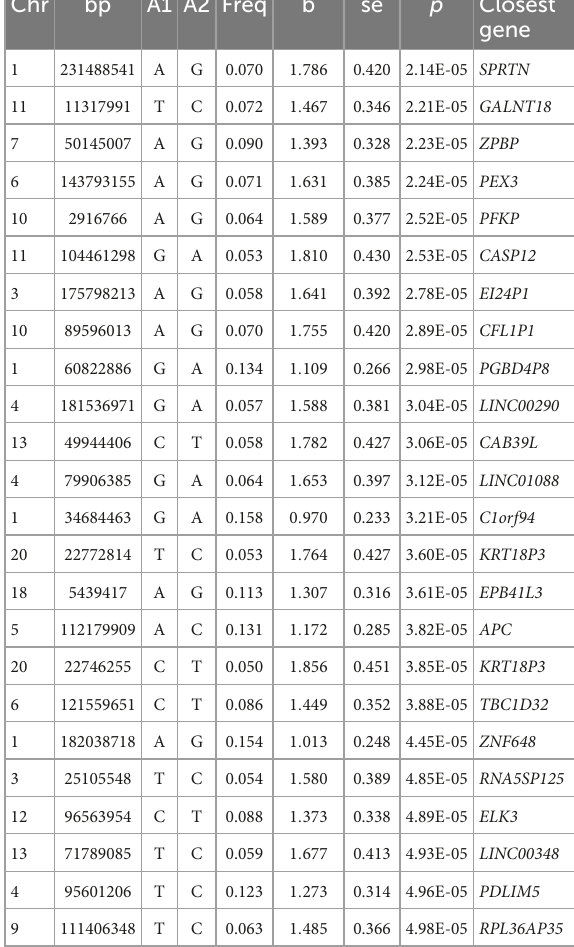
TABLE 1 Genetic loci associated with vascular endothelial function after adjusting for age and sex.